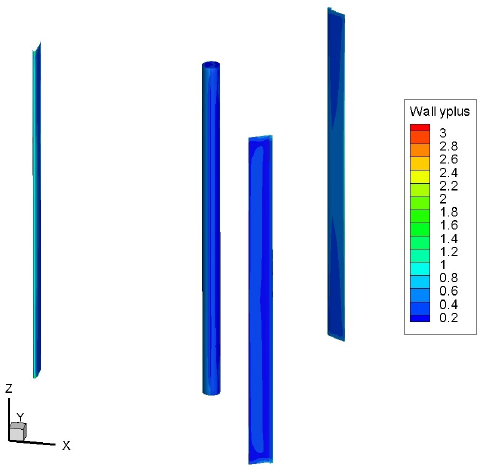
Figure 13. y + distribution around J-shaped blade and spindle (TSR = 2.96).